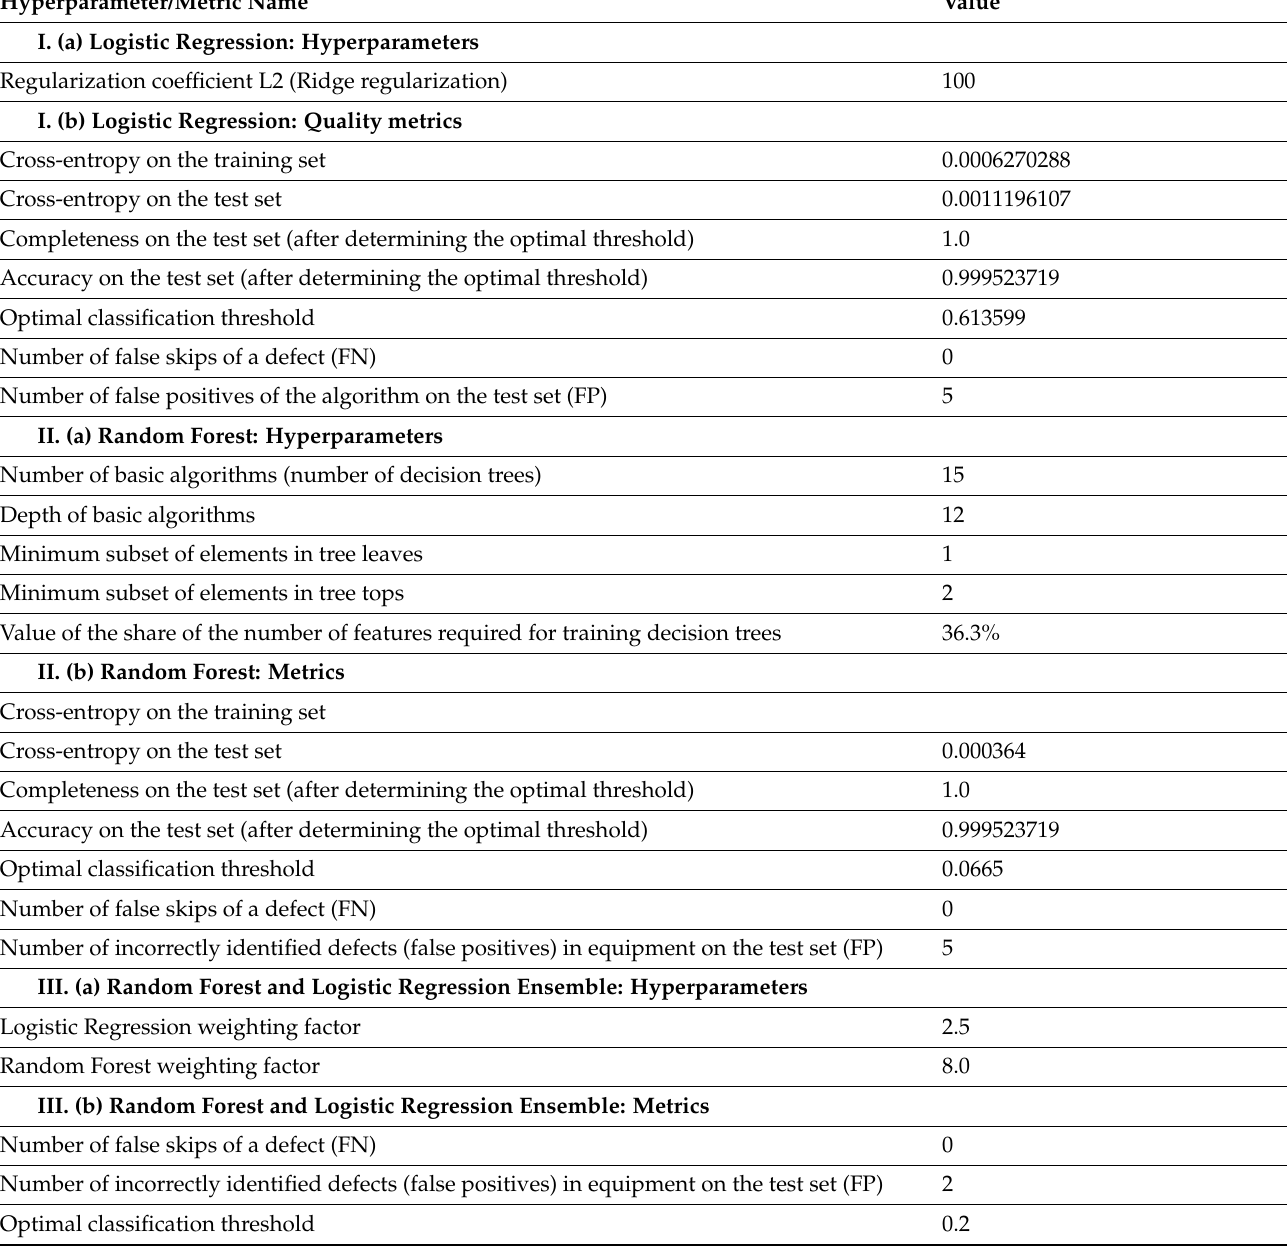
Table 2. Hyperparameters of tuned machine learning models and quality